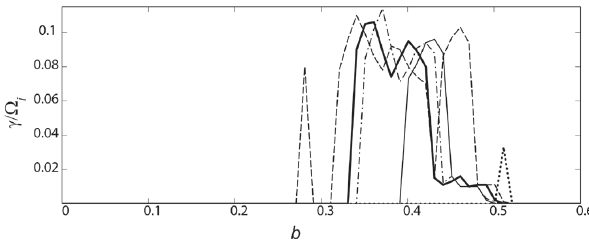
Fig. 3. Plots of the growth rate normalized by the ion gyrofrequency (k y ρ i ) 2 vs. b ≡ for the IEDD instability that develops in a nonuni- 2 form electric field configuration shown in Fig. 2, bottom right panel. The dashed line refers to ω r = 0 . 94, thick solid line to ω r = 0 . 96, dashed-dotted line to ω r = 0 . 98, and thin solid line to ω r = 0 . 99, where ω r is the real frequency normalized by (cid:127) i . Other parameters are τ = 0 . 5, V d /V te = 0 . 1 and u ≡ k || /k ⊥ = 0 . 1. The dotted line indicates a CDEIC solution that would appear (at ω r /(cid:127) i = 1 . 245) if the nonuniform electric fields were removed, V d /V te increased to 0.2 and u taken as 0.05. The CDEIC solution degenerates for τ >0.5.